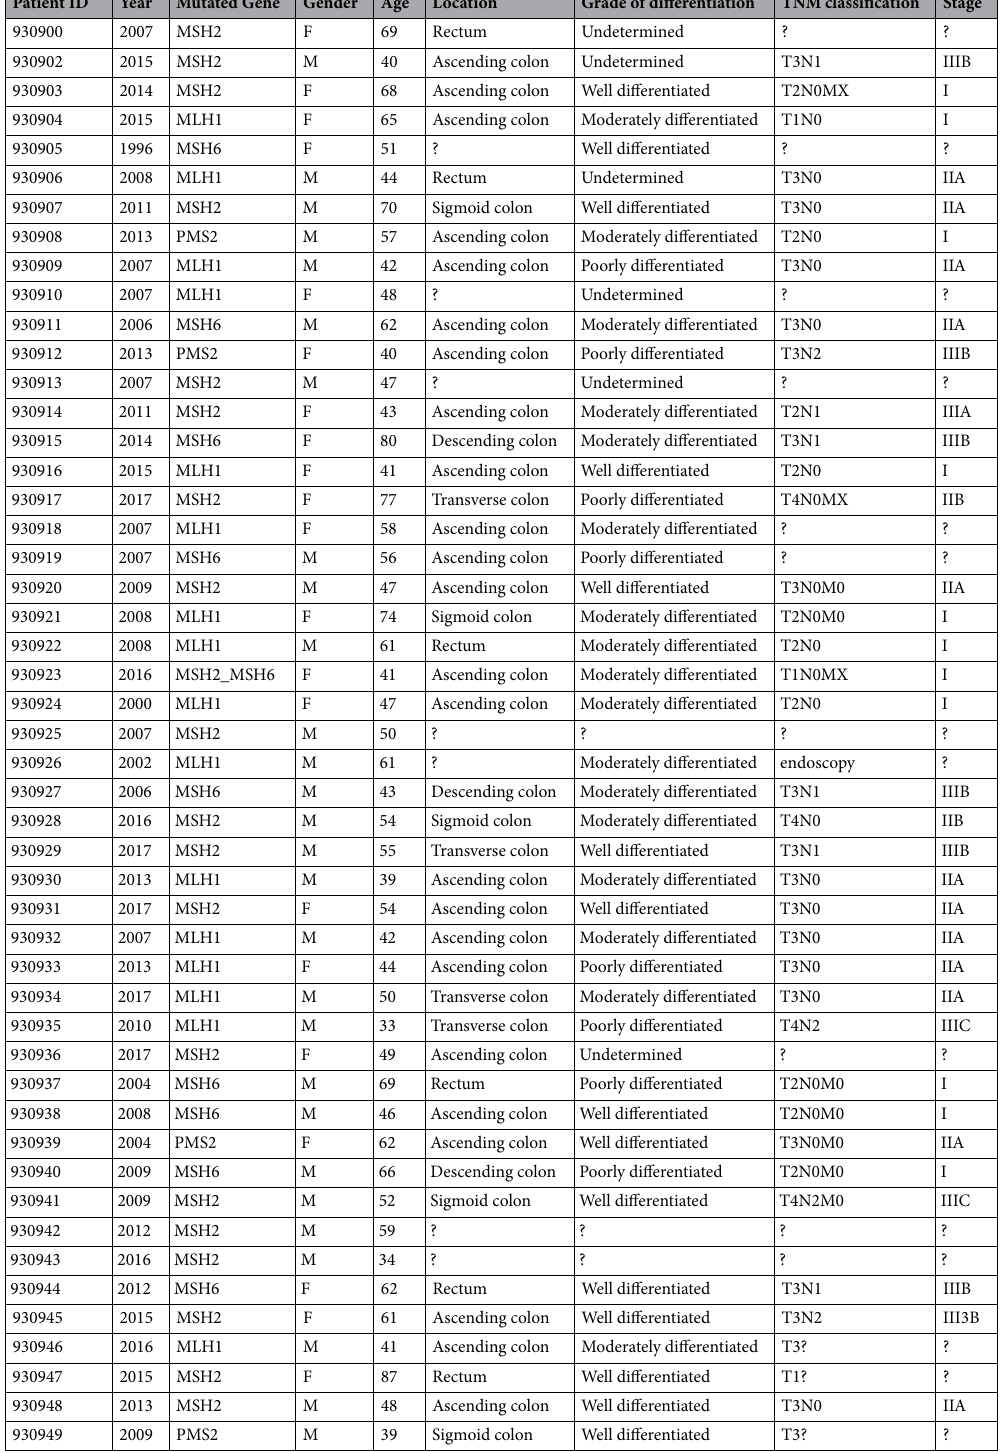
Table 1. List of the patients with sample identification, year of collection, mutated gene, patient gender, age, tumor location, grade of differentiation, TNM classification and stage. Question mark (?) indicates data unknown or not